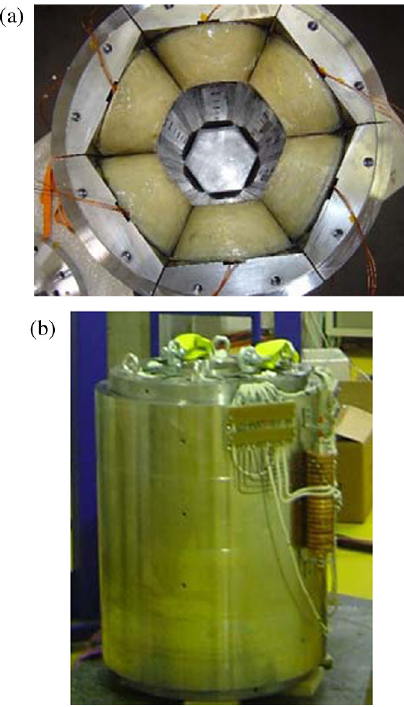
FIG. 8. Fabricated SECRAL magnet assembly and its detailed coil